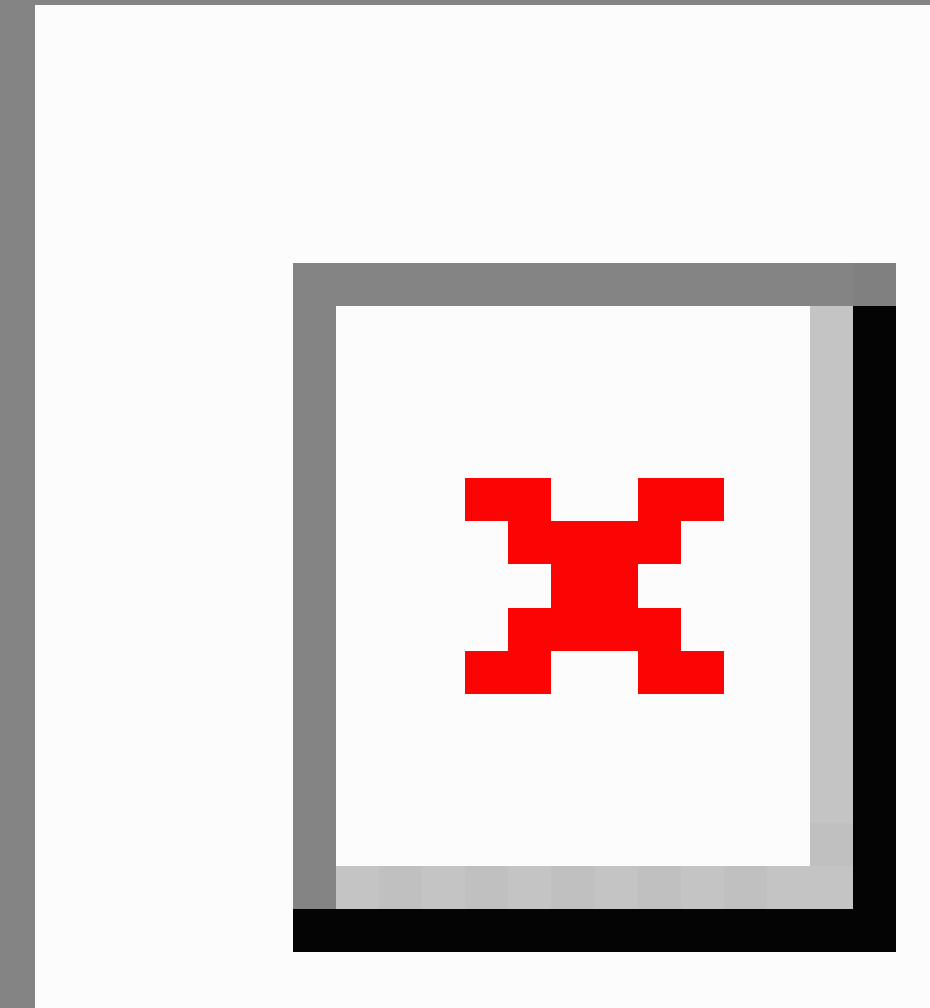
Figure 3. Flowchart of patient